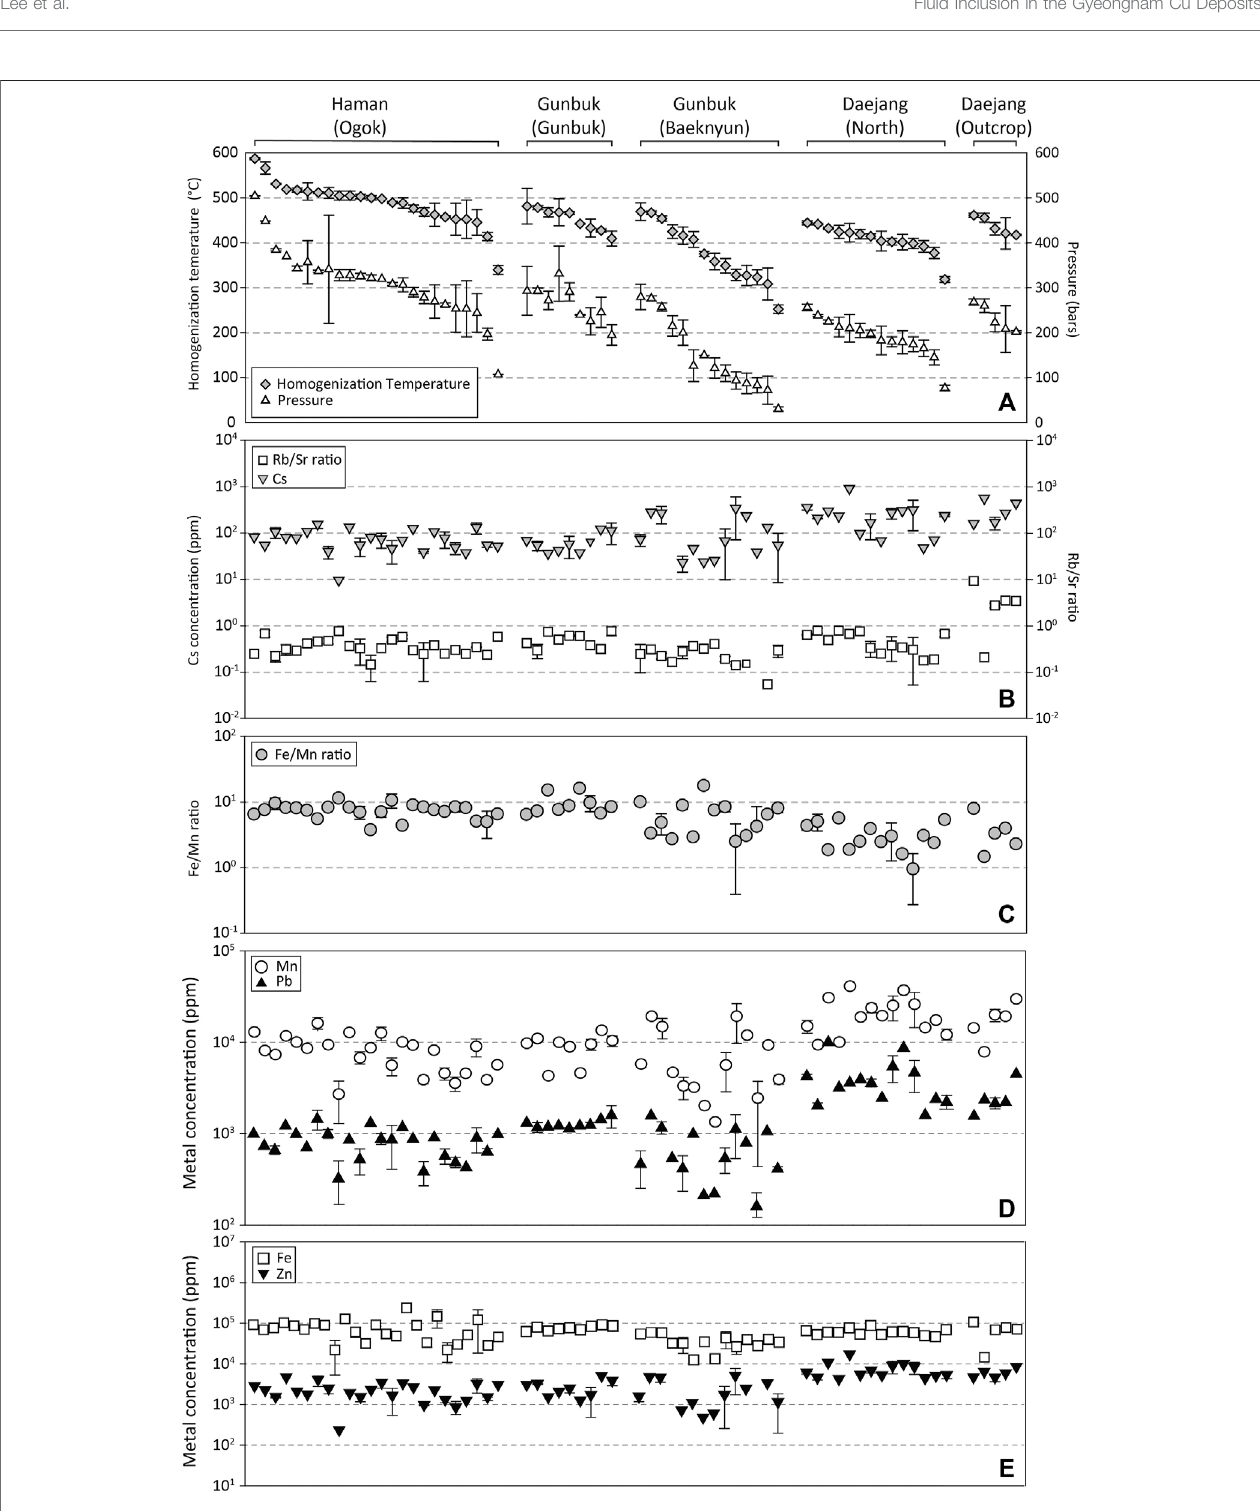
FIGURE 13 | Rb/Sr and Fe/Mn ratio, and concentrations of Cs, Mn, Pb, Fe, and Zn plotted in order of decreasing homogenization temperatures (T h ) of brine inclusion assemblages in orebodies of the Haman, Gunbuk, and Daejang deposits. (A) T h and calculated P of brine inclusion assemblages. (B) Rb/Sr ratios and Cs concentrations of brine inclusion assemblages. Rb/Sr ratios and Cs concentrations in the Haman and Gunbuk deposits were lower than in the Daejang deposit. (C) Fe/ Mn ratios were lower in the Daejang deposit than in the Haman and Gunbuk deposits. (D) Concentrations of Mn and Pb, and (E) Fe and Zn in brine inclusion assemblages. Mn, Pb, and Zn concentrations in the Daejang deposit were higher than in the Haman and Gunbuk deposits.